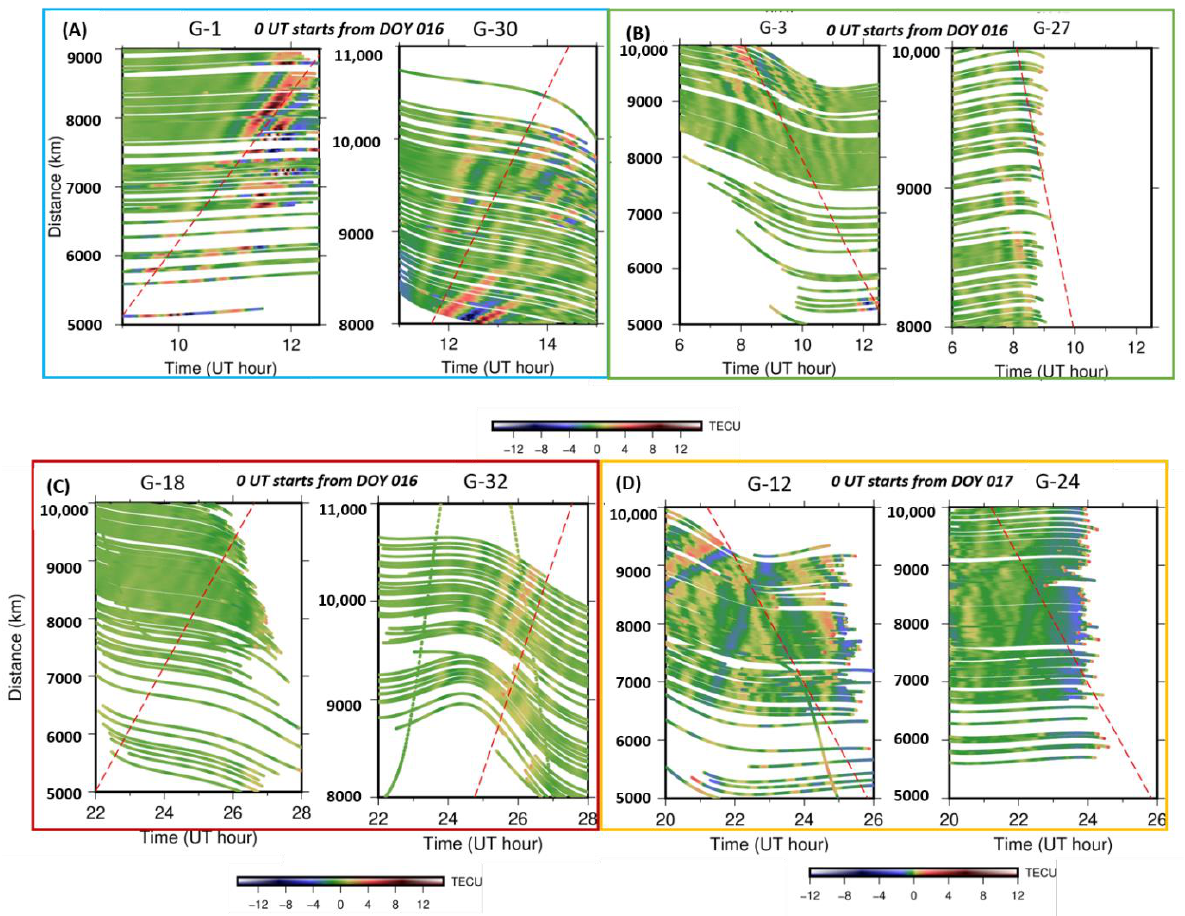
Figure 4. Wavelet-transformed STEC time series expressed as a function of time (horizontal axis) and distance from the volcano (vertical axis) for G1 and G30 ( A ) for the first LW passage in Table 1. ( B – D ) show results of the wavelet transformation for detecting the second, third, and fourth LW passages, respectively. All passages are consistent with expected passage times and velocities of LW (0.3 km/s), given as red dashed lines. We used a wavelet period of ~30 min here. See Figure A5 for the same figure drawn using a shorter wavelet period (~12 min).